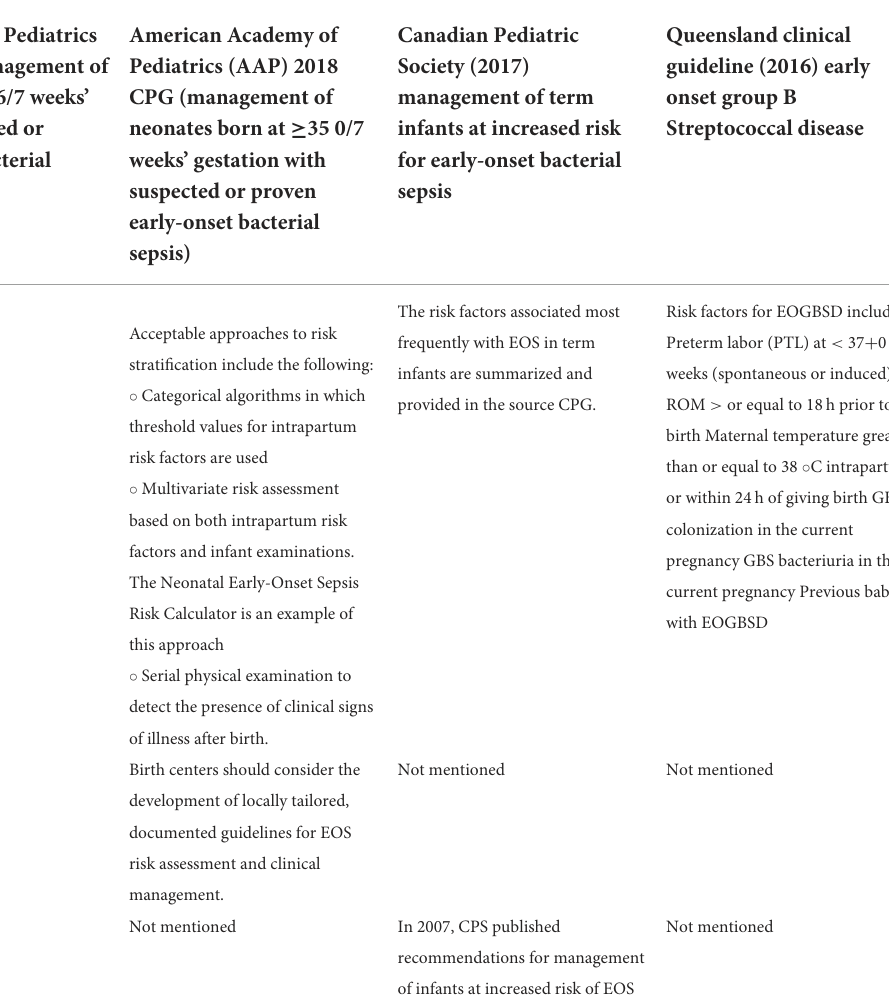
TABLE 3 Recommendation matrix table for the five eligible source